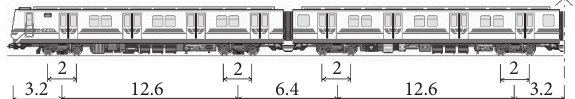
Figure 1: Schematic diagram of the urban train in the test (unit: m).